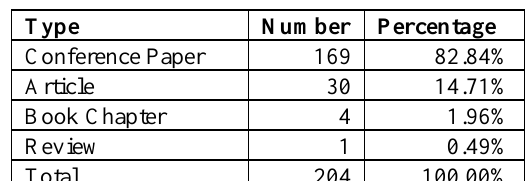
Table 7. Distribution of considered publications by type